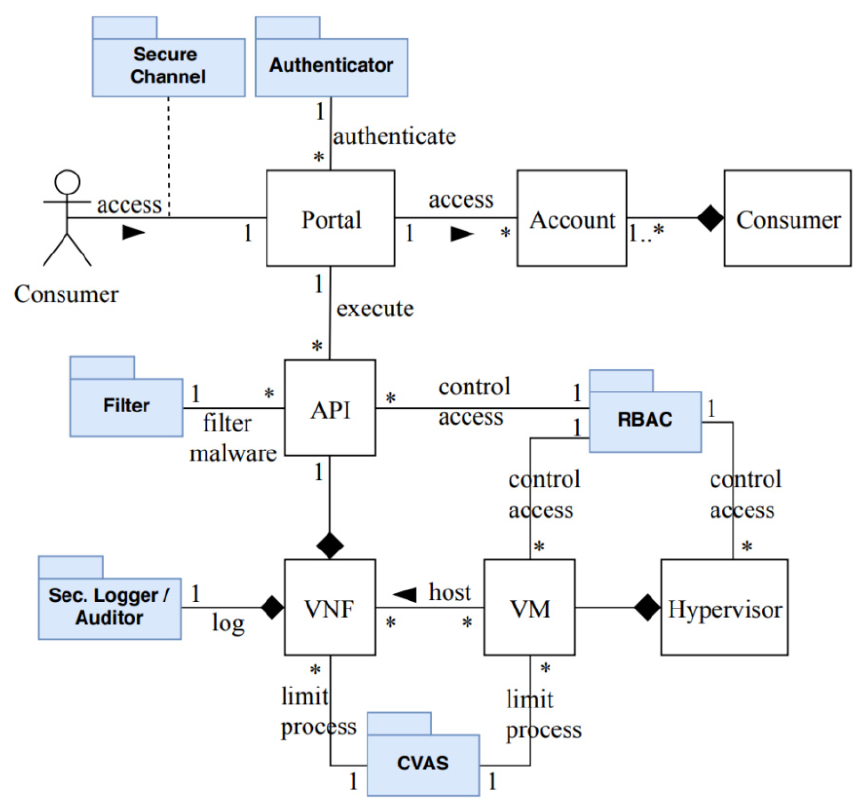
Figure 10. A partial security reference architecture for NFV .